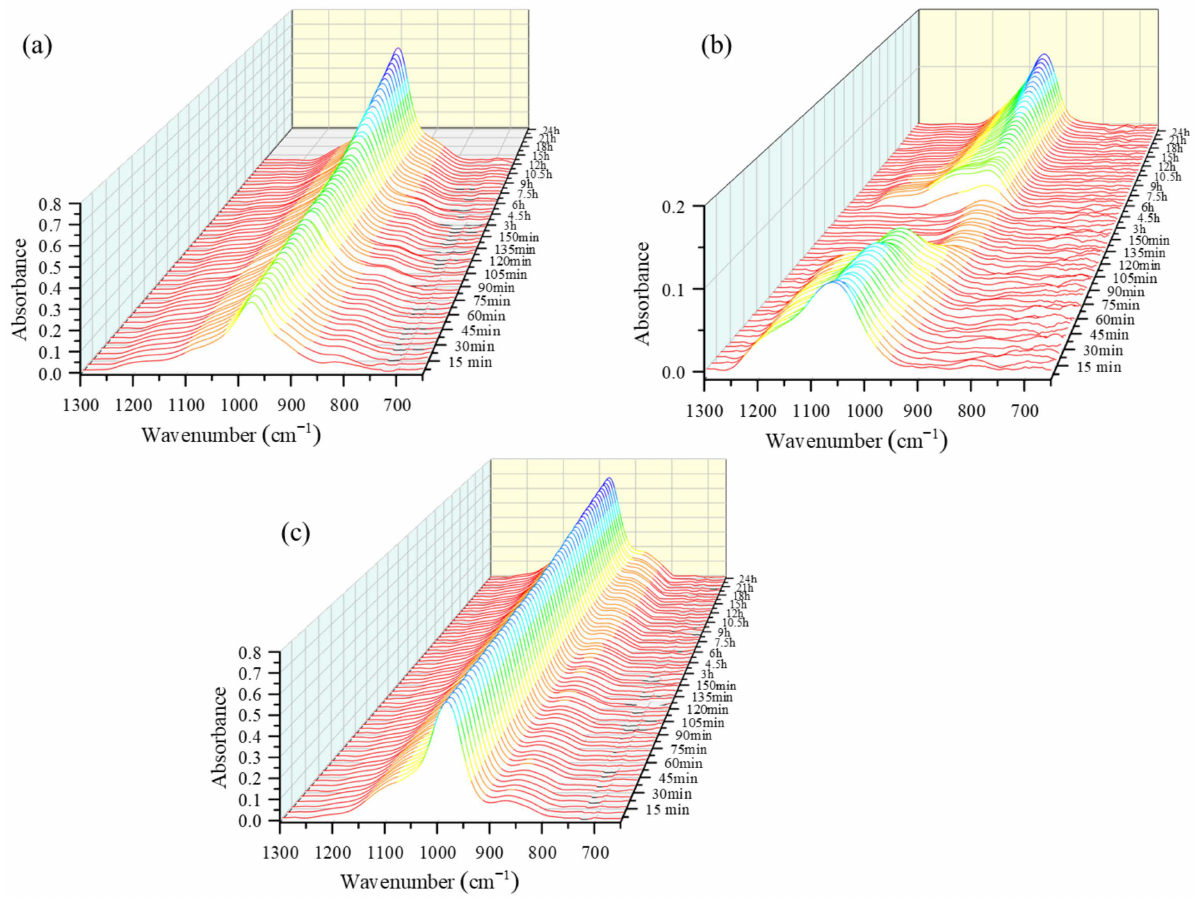
Figure 1. Three-dimensional waterfall attenuated total reflectance-Fourier transform infrared (ATR- FTIR) spectra of ( a ) mixed solution-based alkali activated material (AAM), ( b ) NaOH solution-based AAM and ( c ) Na 2 SiO 3 solution-based AAM, at different time points.